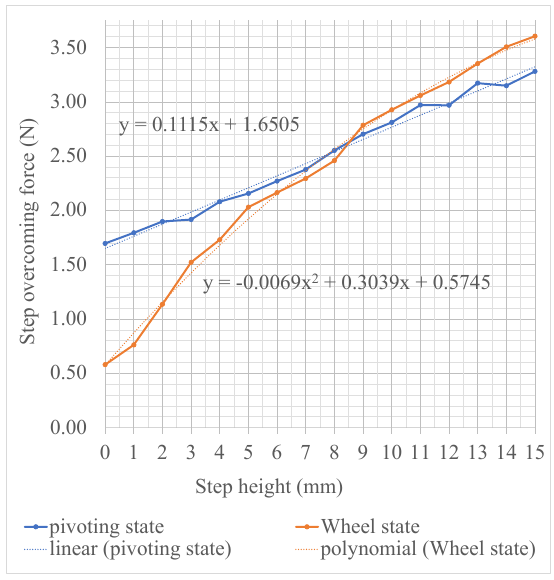
Figure 20. Graph of strength to get over a step.